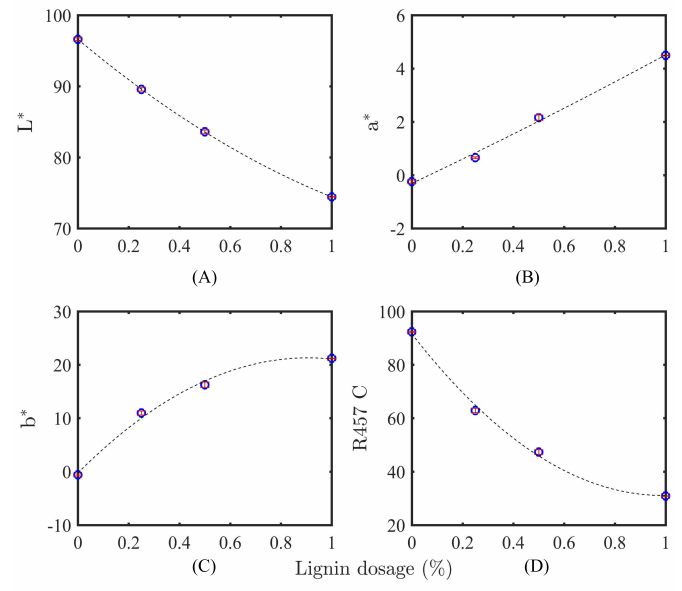
Figure 3. The effect of different lignin dosages (wt %) on the optical properties of fabricated membranes; ( A ) L ∗ (lightness/darkness), ( B ) a ∗ (greenness/redness), ( C ) b ∗ (blueness/yellowness), ( D ) ISO brightness (R457